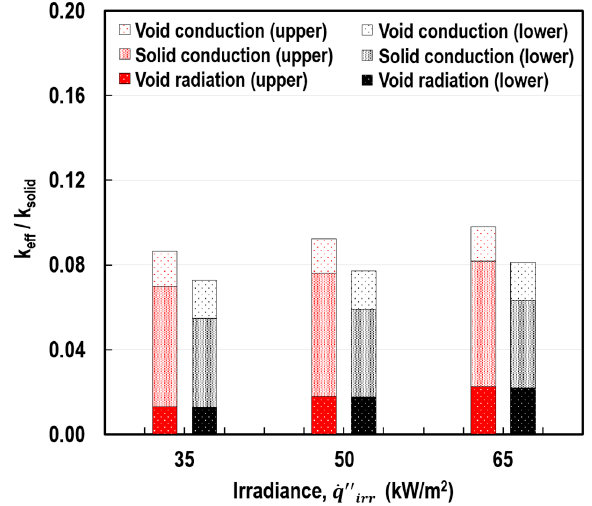
Figure 20. Variations in the k eff / k solid ratio and the individual contributions of the heat transfer modes according to 𝑞(cid:4662) (cid:2919)(cid:2928)(cid:2928) (cid:4593)(cid:4593) at L = 3 mm, δ cell = 258 μ m, and Φ = 0.895.